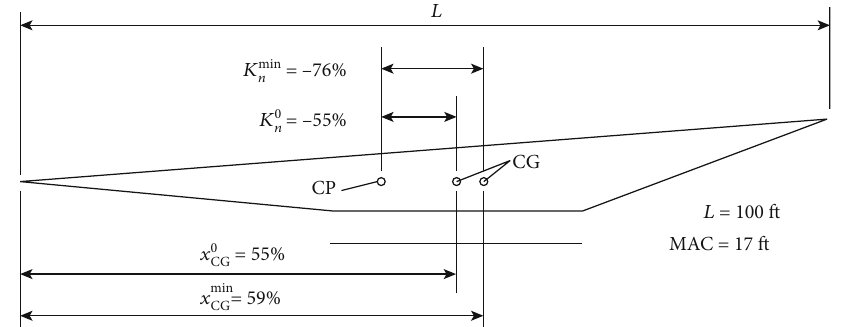
Figure 9: Sketch of HFV with the minimum static stability margin.